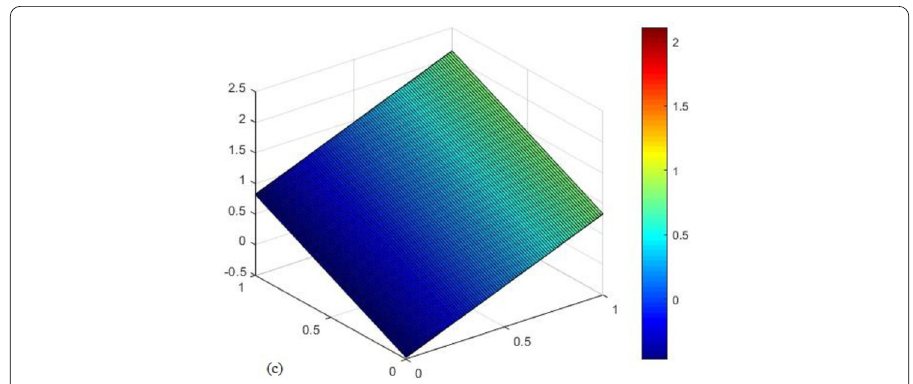
Figure 14 The graph of exact and approximate solution of (cid:14) ( χ , ϕ , η ) at ϒ = 1 of Example